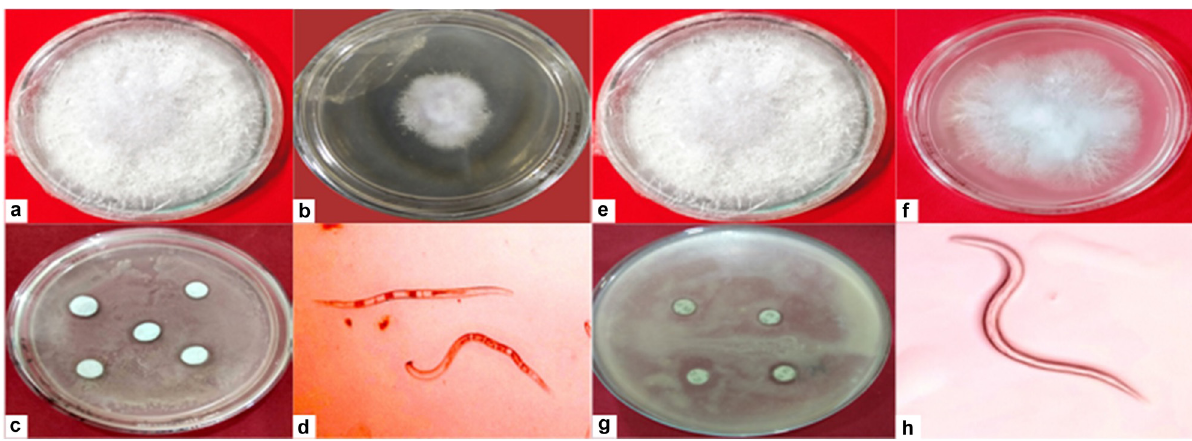
Figure 1: ( a and e ) P. vexans growth on PDA medium. ( b ) P. vexans growth on PDA medium with 0.20 mg/mL suspension of SiO 2 - NPs. ( f ) P. vexans growth on PDA medium with 0.20 mg/mL solution of TiO - NPs. ( c ) Inhibition zone present around a paper disk dipped in 2 0.20 mg/mL suspension of SiO 2 - NPs inoculated with R. solanacearum. ( g ) Inhibition zone formed around a paper disk dipped in 0.20 mg/mL suspension of TiO 2 - NPs. ( d ) Treated J 2 of M. incognita with 0.20 mg/mL suspension of SiO 2 - NPs for 24 h. ( h ) Treated J 2 of M. incognita with 0.20 mg/mL TiO 2 - NPs suspension for 24 h. Figure 1c and g ) . An inhibition zone of 0.20 mg/mL of - NP and TiO - NP was recorded at 0.62 and 0.51 mm, SiO 2 2 respectively, after 48 h of incubation ( Table 1 ) .